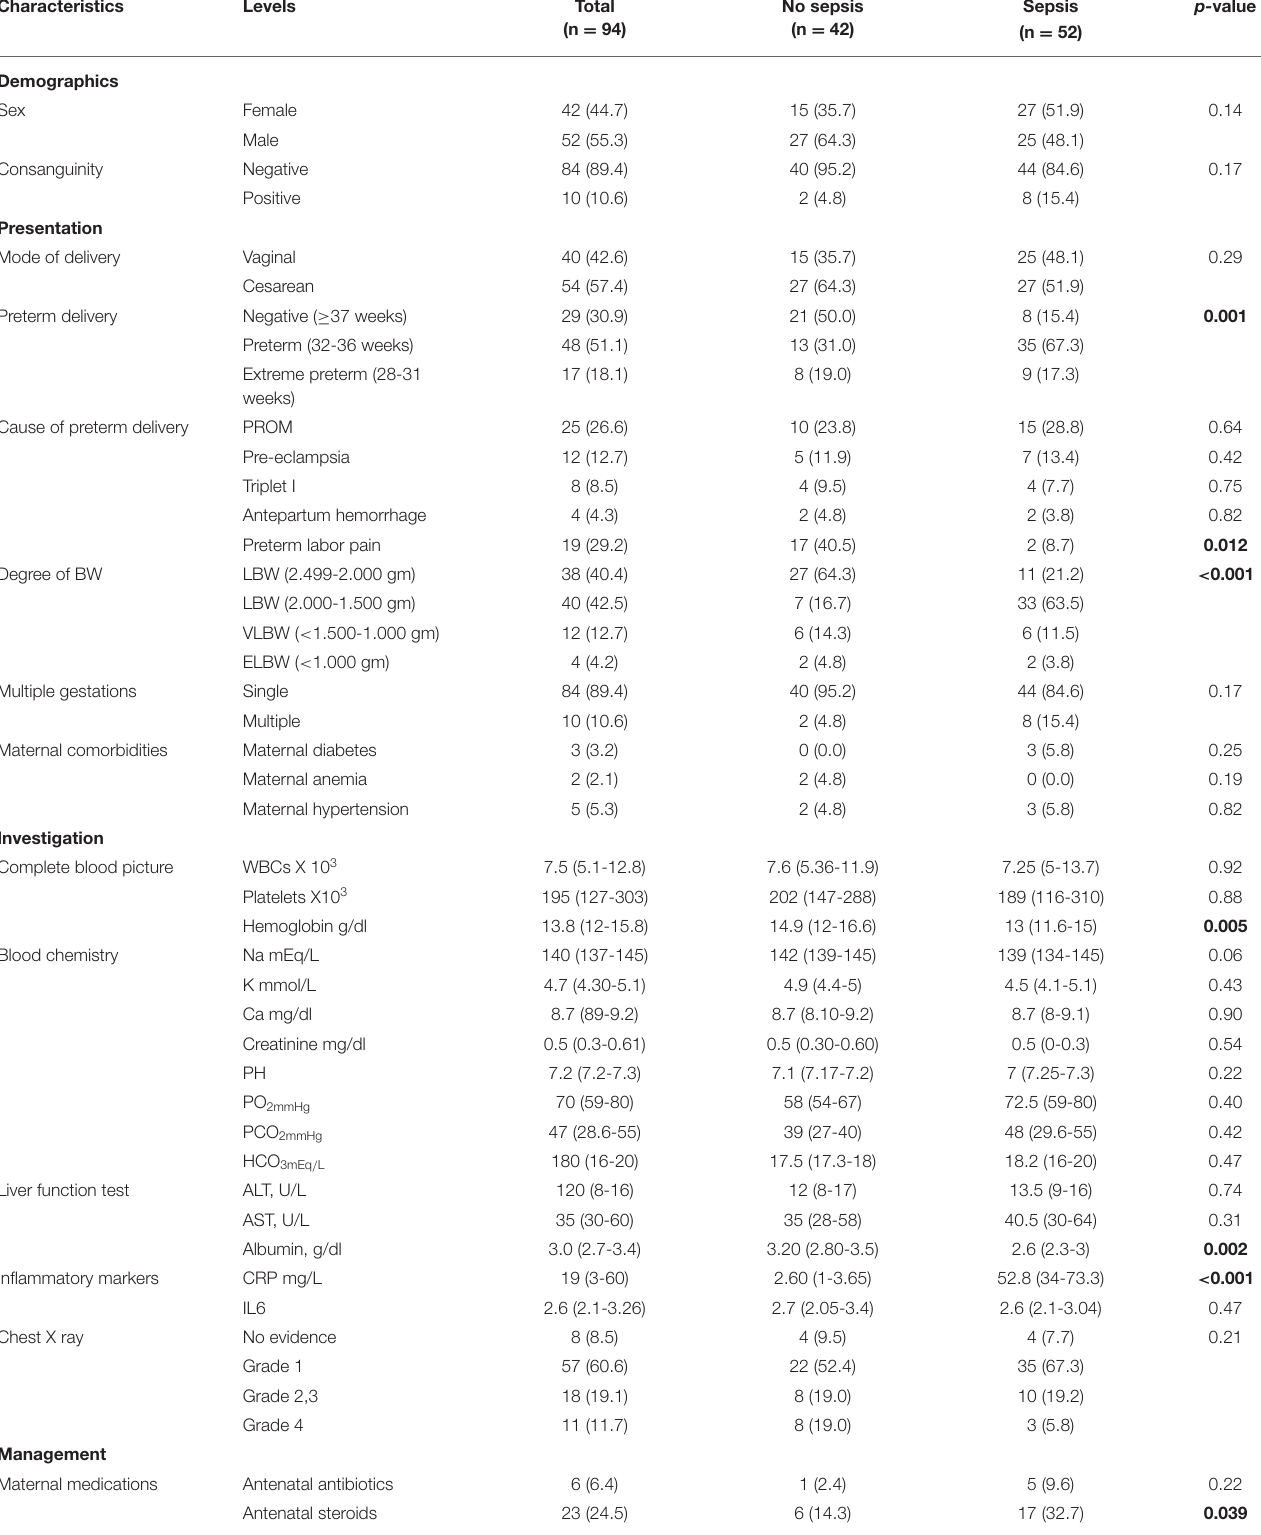
TABLE 2 | Characteristics of neonates with lung disease cohort according to subsequent complications with sepsis.